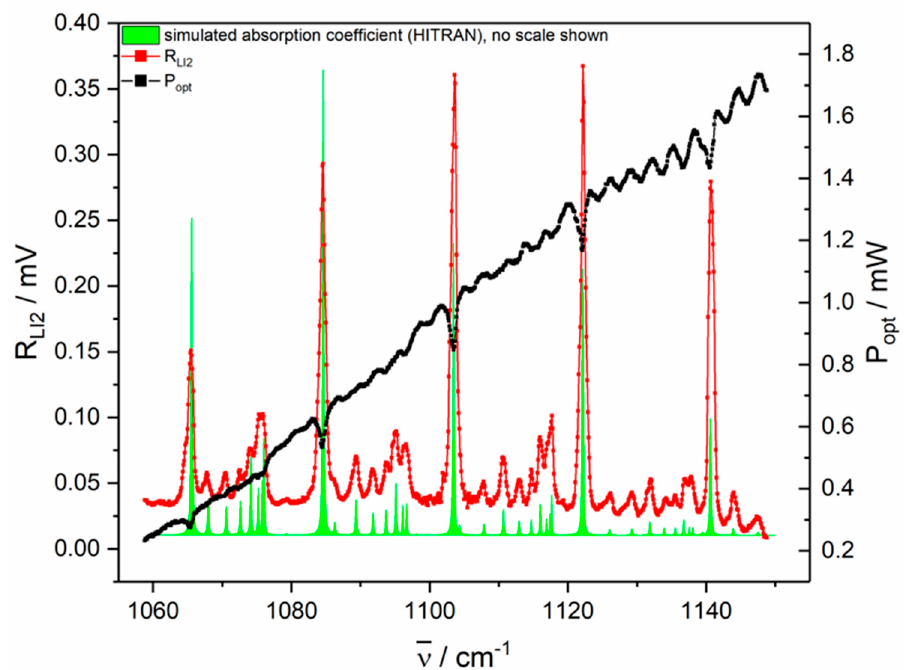
Figure 4. Comparison of transmitted power (black), photoacoustic signal (red), and simulated absorption (green) for 1.5% ammonia in synthetic air.